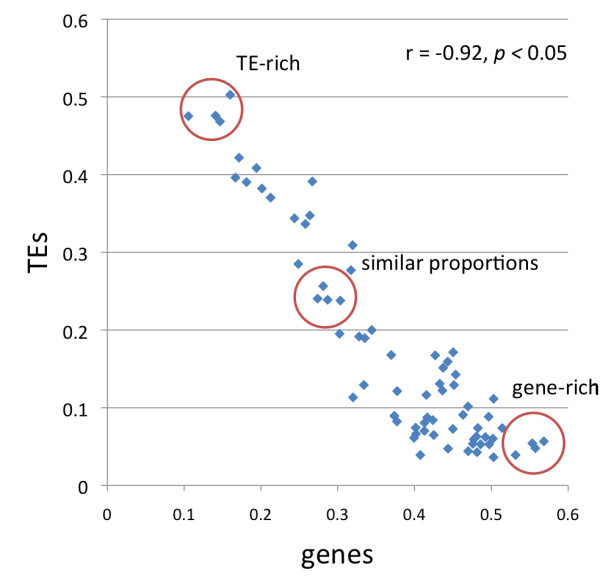
Correlation of the proportional coverage between genes and TEs in scaffolds ≥ 1Mb. Circled points indicate scaffolds selected for further analysis. TE-rich scaffolds (scaffolds 380, 50, 29 and 127); scaffolds with similar proportions of TEs and genes (scaffolds 33, 222, 151 and 132); gene-rich scaffolds (123, 464, 898 and 605).